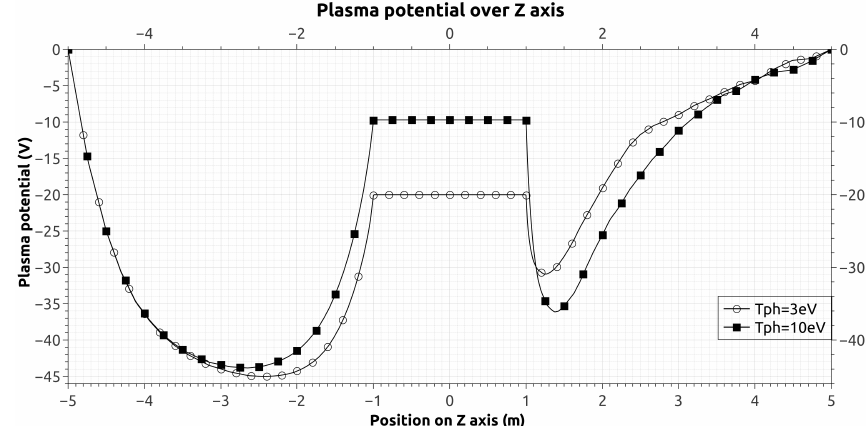
Fig. 6. Cross comparison simulation B (SPIS): plot along the z-axis of the plasma potential. The circled line represents the potential for a photoelectron emission temperature centered on 3eV, the squared line is for a temperature of 10eV.